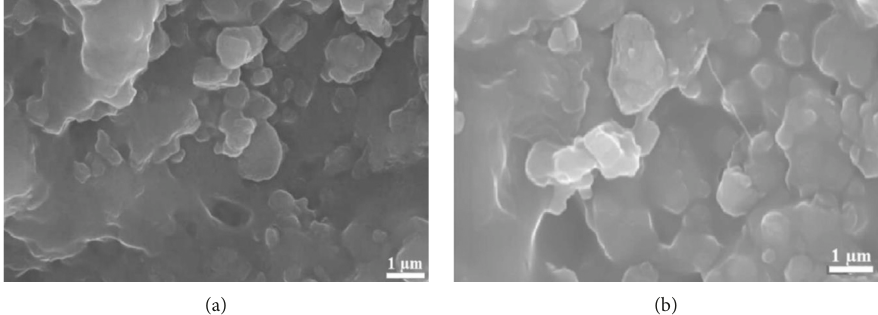
Figure 6: SEM images of silicone rubber/TiO Table 1: Conductivity of micro/nanocomposites relative to the concentration of TiO % nano-TiO 2